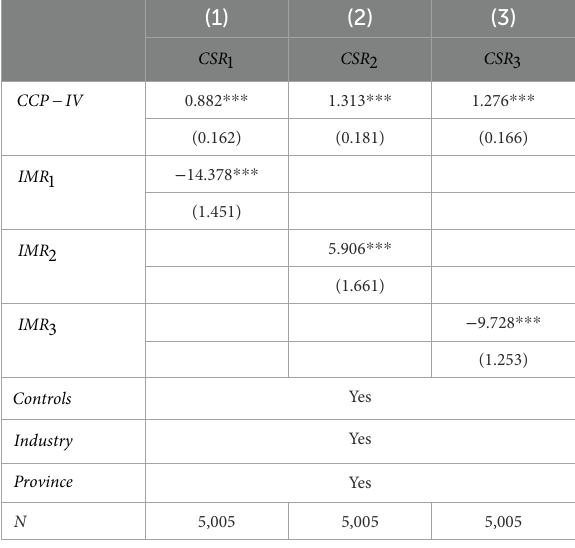
TABLE 8 Instrumental variable test: Heckman two-step